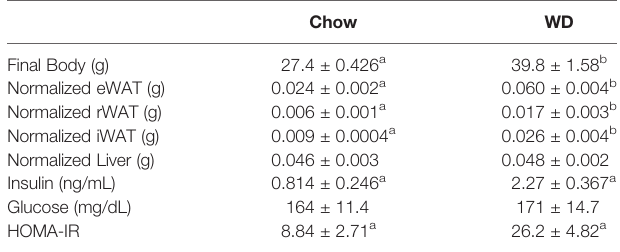
TABLE 1 | Final body weight, tissue weights normalized to body weight and serum measures for the three dietary